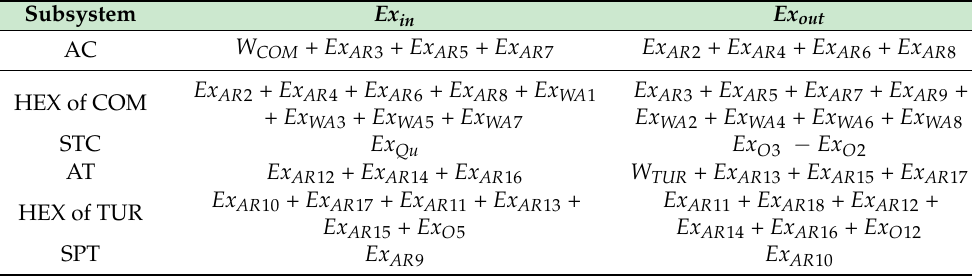
Table 2. Expressions of input and output exergy of each